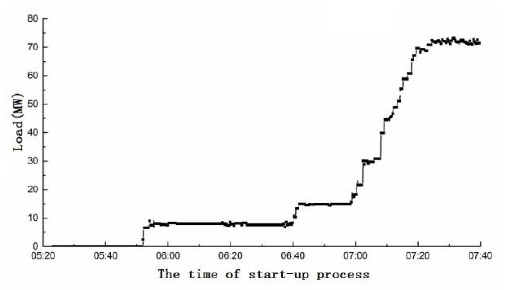
Figure 13. The load change during the start-up period.